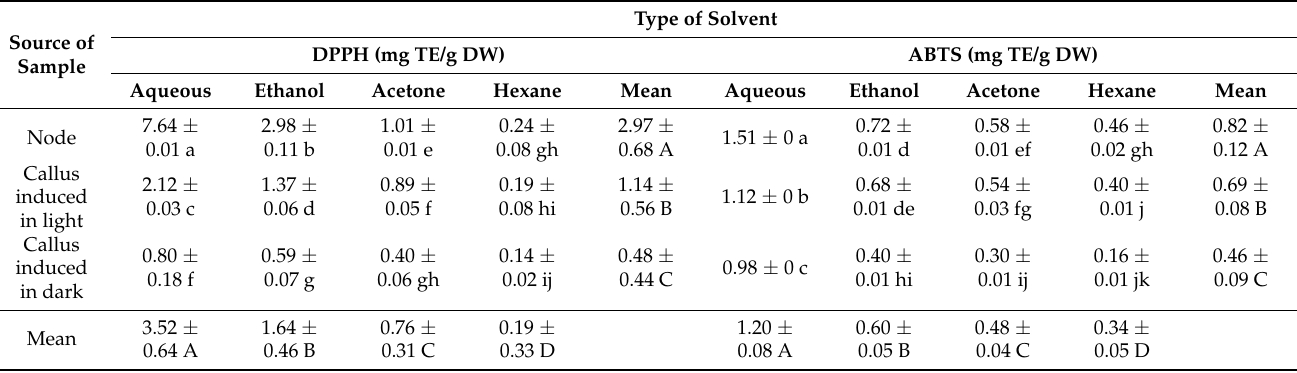
Table 4. 2,2-diphenyl-1-picryl-hydrazyl-hydrate (DPPH) free radical scavenging activity and 2,2- azino- bis (3-ethylbenzothiazoline-6-sulfonic acid) (ABTS) scavenging activity of node and in vitro- induced calli of Bougainvillea glabra .